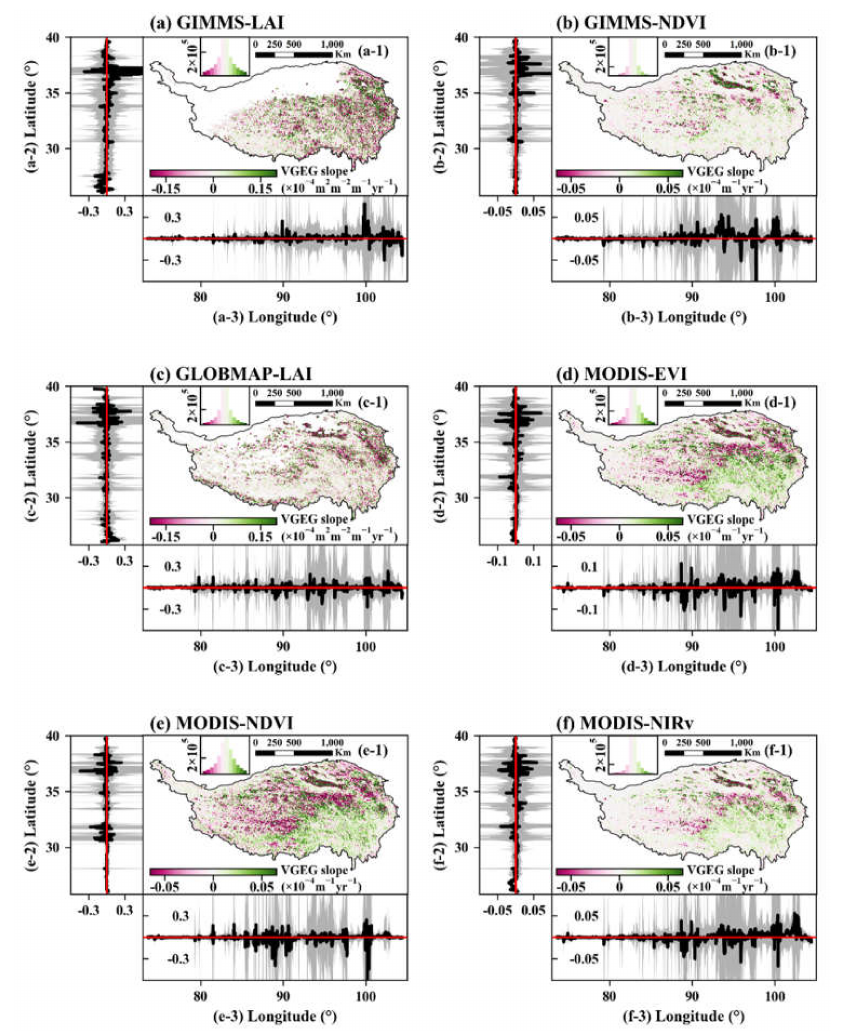
Figure 8. Spatial pattern of the VGEG variation from 2001 to 2016 ( a-1 – f-1 ). The value frequency inset is in the upper-left of each main figure. The subfigures ( e-2 – f-2 ) and ( e-3 – f-3 ) show the latitudinal and longitudinal distributions of VGEG variation; the shadow regions represent one standard